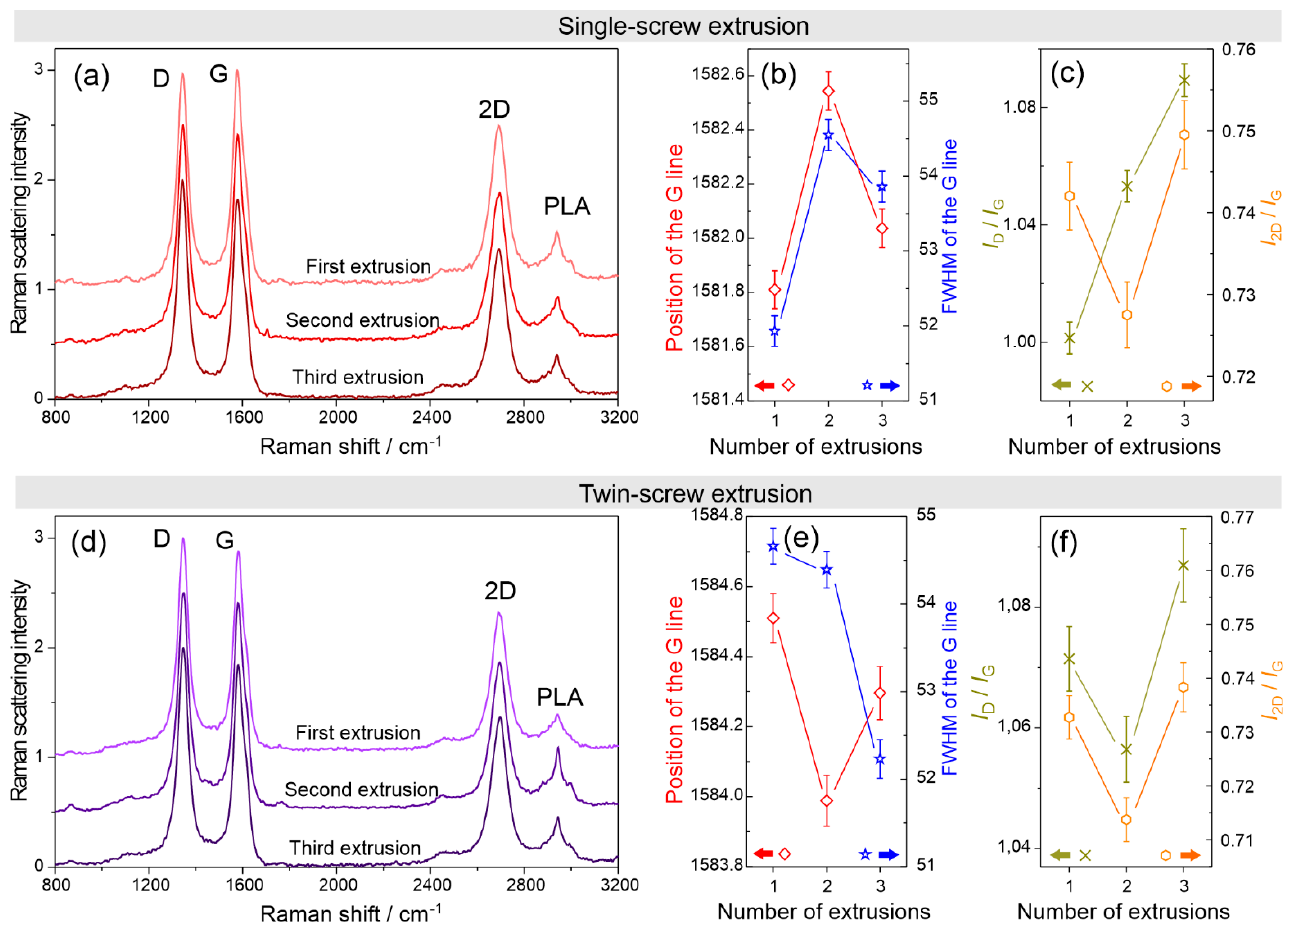
Figure 6. Raman spectroscopy of the PLA/MWCNT composites. ( a ) Raman spectra of PLA/MWCNT composites subjected to the single ‒ screw extrusion. ( b ) Position and FHWM of the G line as a function of the number of single ‒ screw extrusions. ( c ) Intensity of the D and 2D line against the intensity of the G line as a function of single ‒ screw extrusions. ( d ) Raman spectra of PLA/MWCNT composites subjected to the twin ‒ screw extrusion. ( e ) Position and FHWM of the G line as a function of the number of twin ‒ screw extrusions. ( f ) Intensity of the D and 2D line against the intensity of the G line as a function of the twin ‒ screw extrusions.